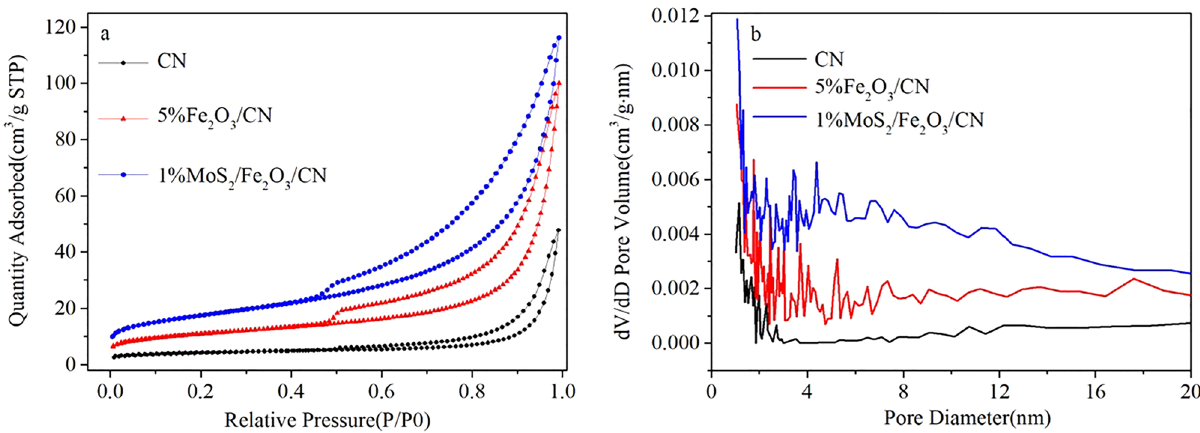
Figure 7. N 2 adsorption–desorption isotherms and pore size distributions of CN, 5%Fe 2 O 3 /CN, and 1% MoS 2 /